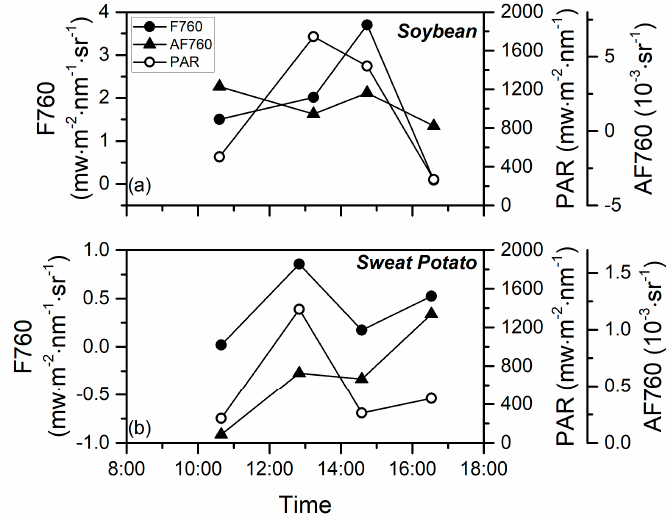
Figure 3. Diurnal patterns of F760, AF760 and simultaneously measured PAR in ( a ) soybean and ( b ) sweet potato.